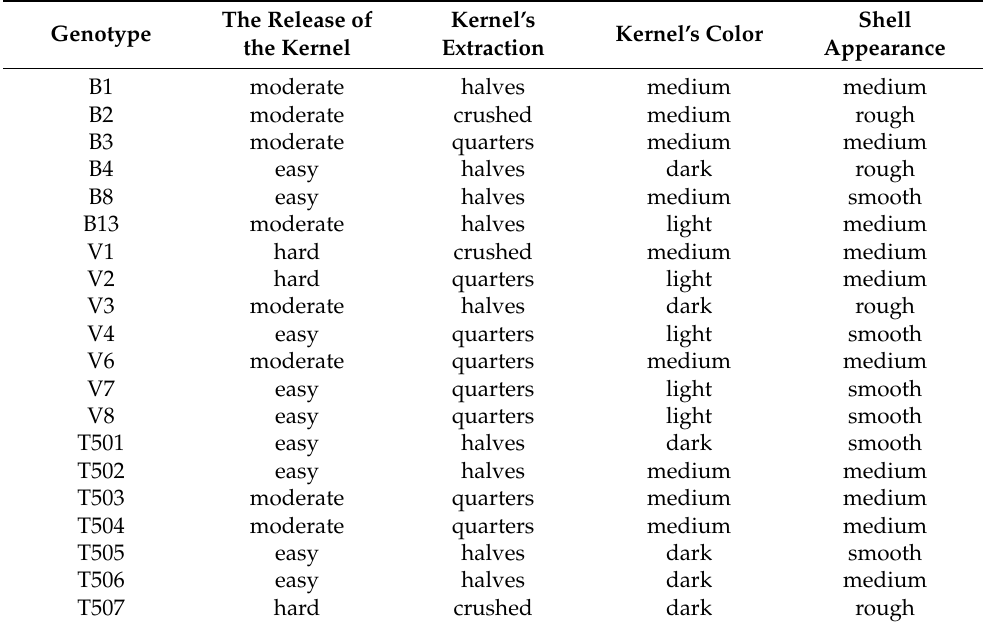
Table 4. External properties of kernel of different genotype from west and north-west of Romania.